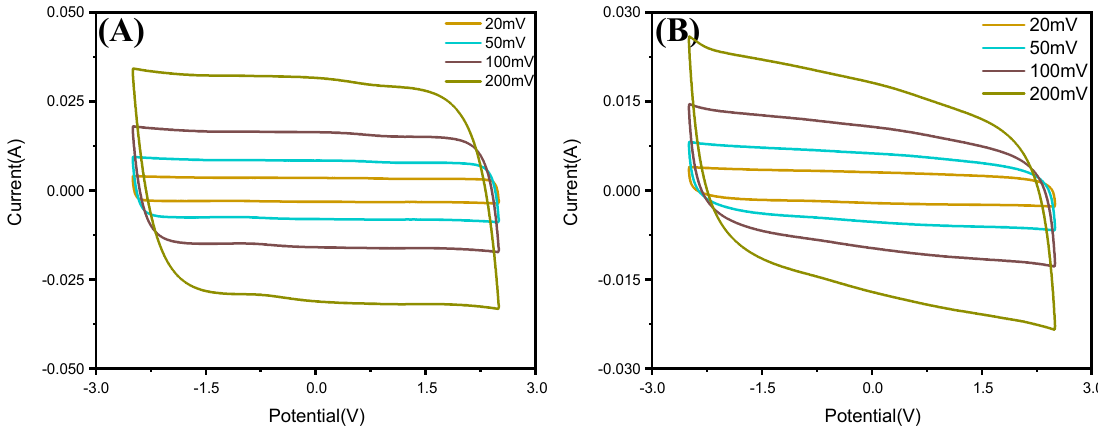
Figure 9. CV plots of symmetric two-electrode capacitors assembled with the ( A ) hot-pressed BI-PI separator and ( B ) commercial TF-4030 cellulose separator.